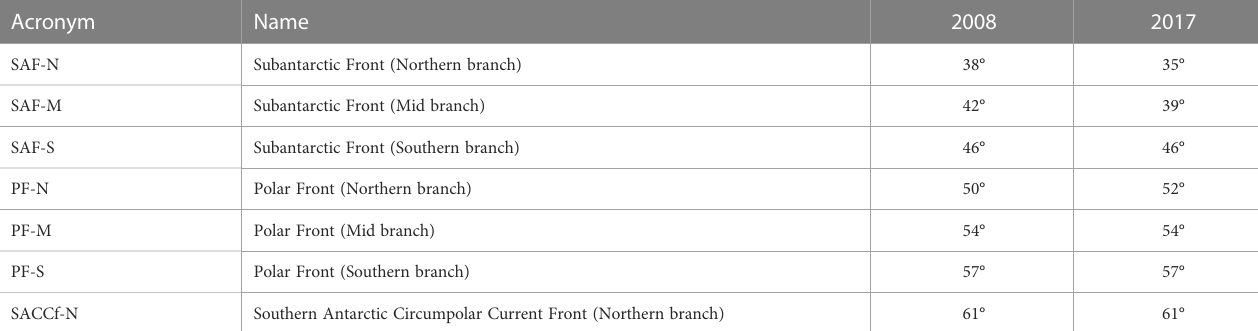
TABLE 1 Acronyms and approximate latitudes of the Polar Front (PF) and Subantarctic Front (SAF), their respective branches, and the Southern Antarctic Circumpolar Current Front (SACCf-N).